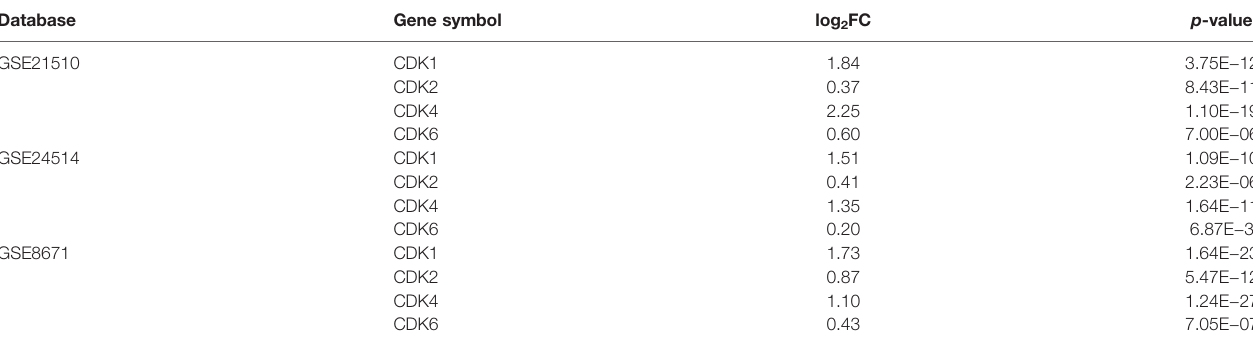
TABLE 2 | The signi fi cance of CDKs in GEO microarrays. Database Gene